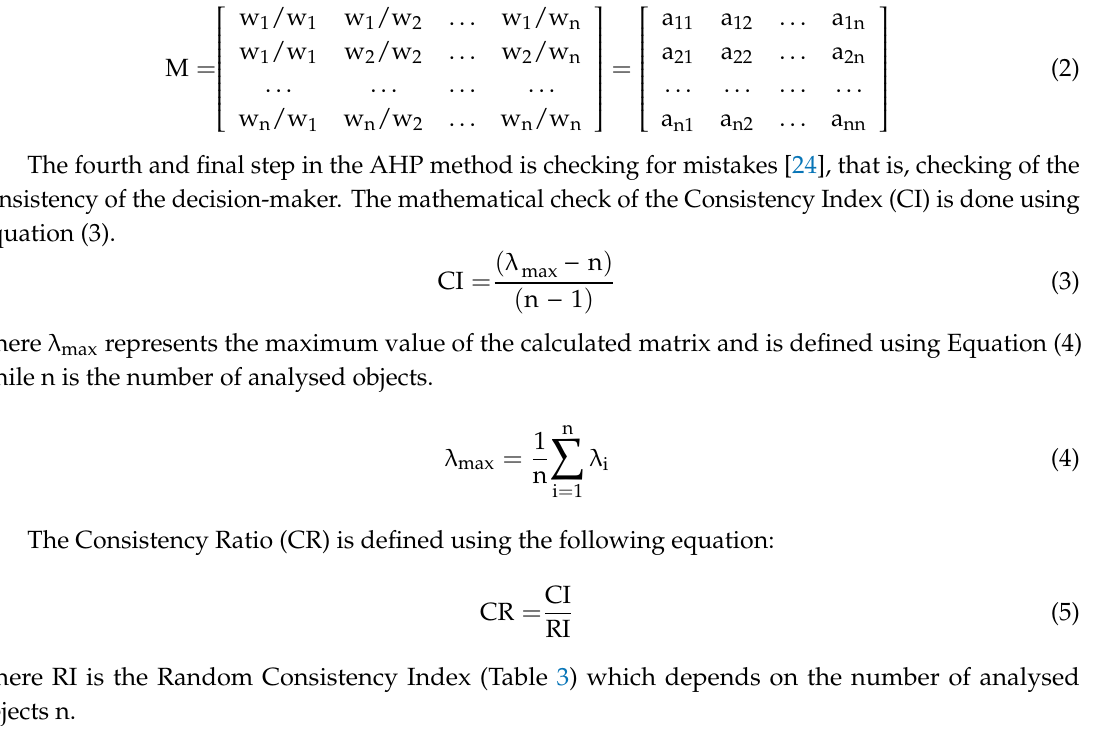
Table 3. The values of the Random Consistency Index (RI) (Saaty,